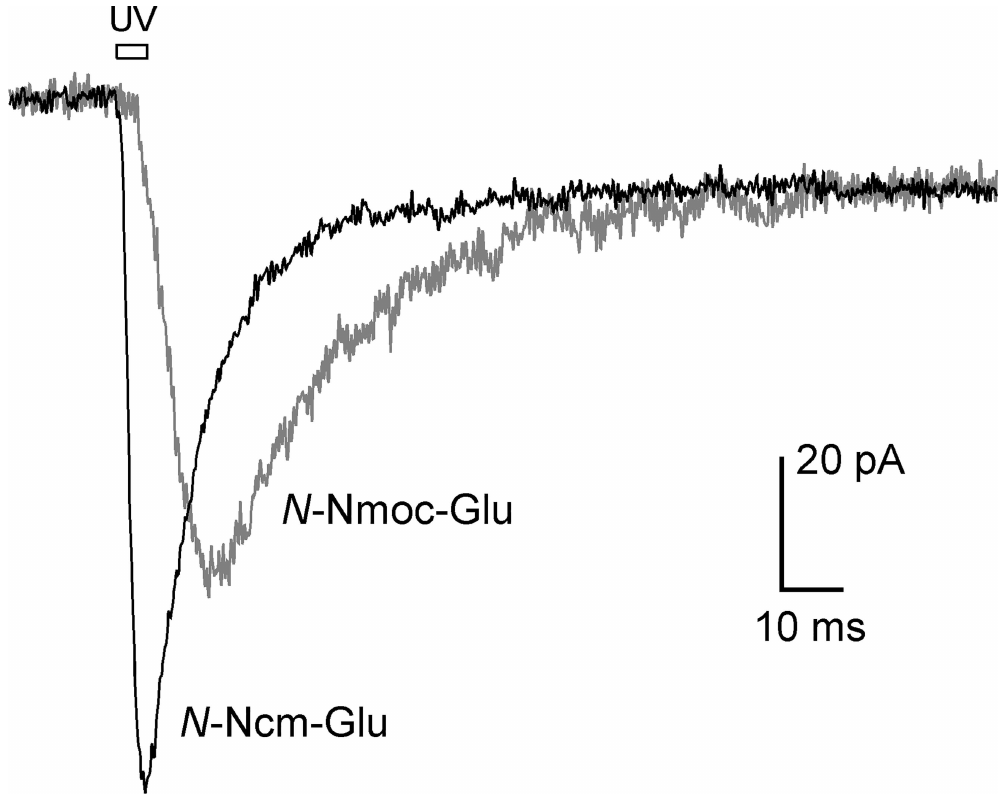
Fig 9. Comparison of ionic currents evoked by photoreleasing N -Ncm-Glu and N -Nmoc-Glu onto cultured hippocampal neurons. Bar above the trace marks the 5-ms durationof the UV laser pulse. Cagedglutamate concentration was 1 mM. Currents shown are the average from 12 cells for N -Ncm-Glu and 7 cells for N -Nmoc-